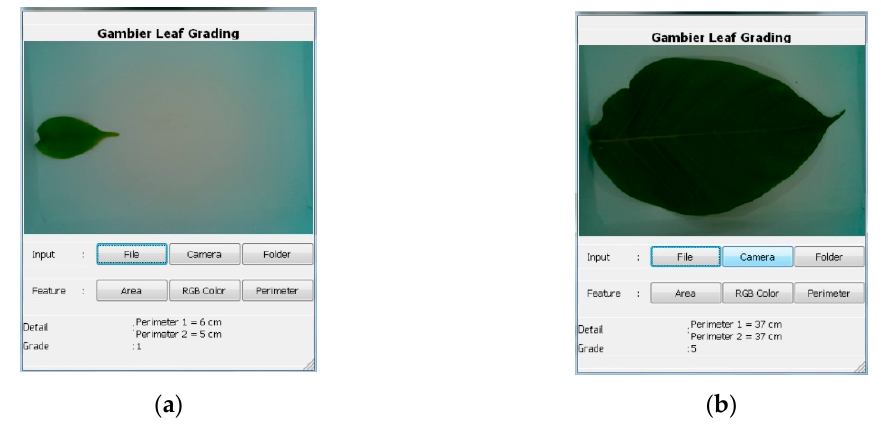
Figure 12. Hardware implementation system: ( a ) Box front view; ( b ) box top view.